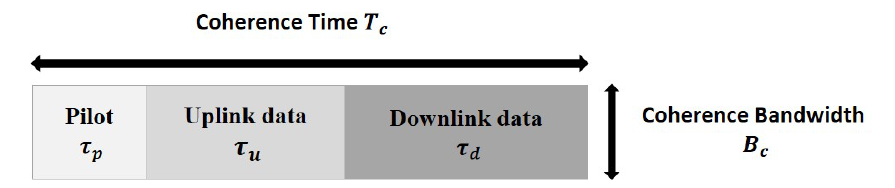
Figure 2. Time-division duplex (TDD)